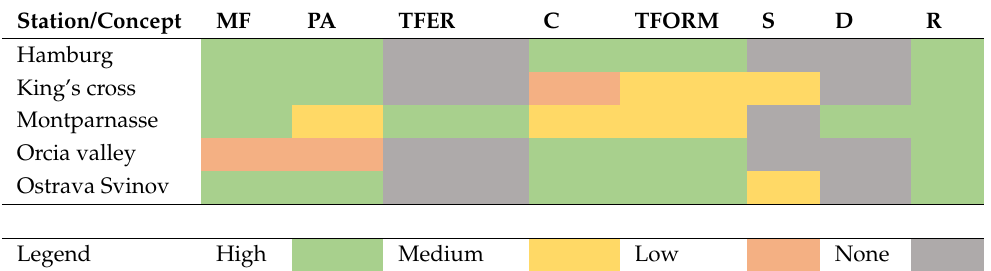
Table 3. Urban configuration analysis. Degree of transformation. Own